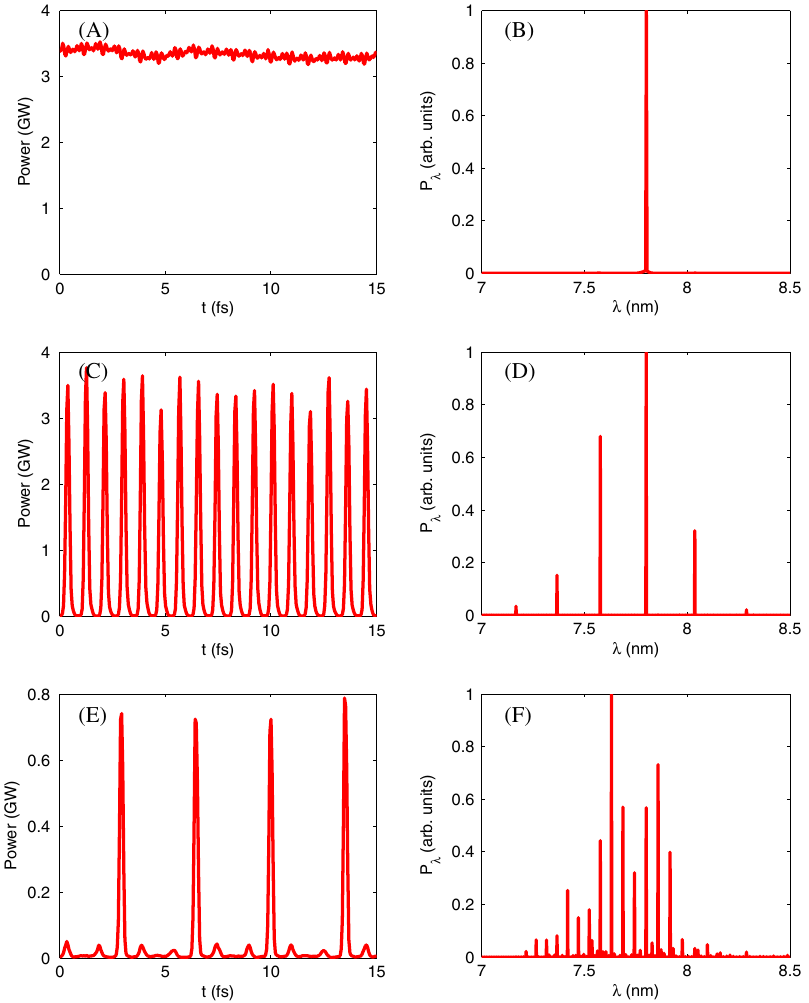
FIG. 6. Radiation pulses close to saturation and the corresponding radiation spectrums for three cases. (a) radiation pulse of conventional EEHG, (b) spectrum of conventional EEHG, (c) radiation pulse of triple-modulator scheme with seed3 off, (d) spectrum of triple-modulator scheme with seed3 off, (e) radiation pulse of triple-modulator scheme with seed3 on, and (f) spectrum of triple- modulator scheme with seed3 on.